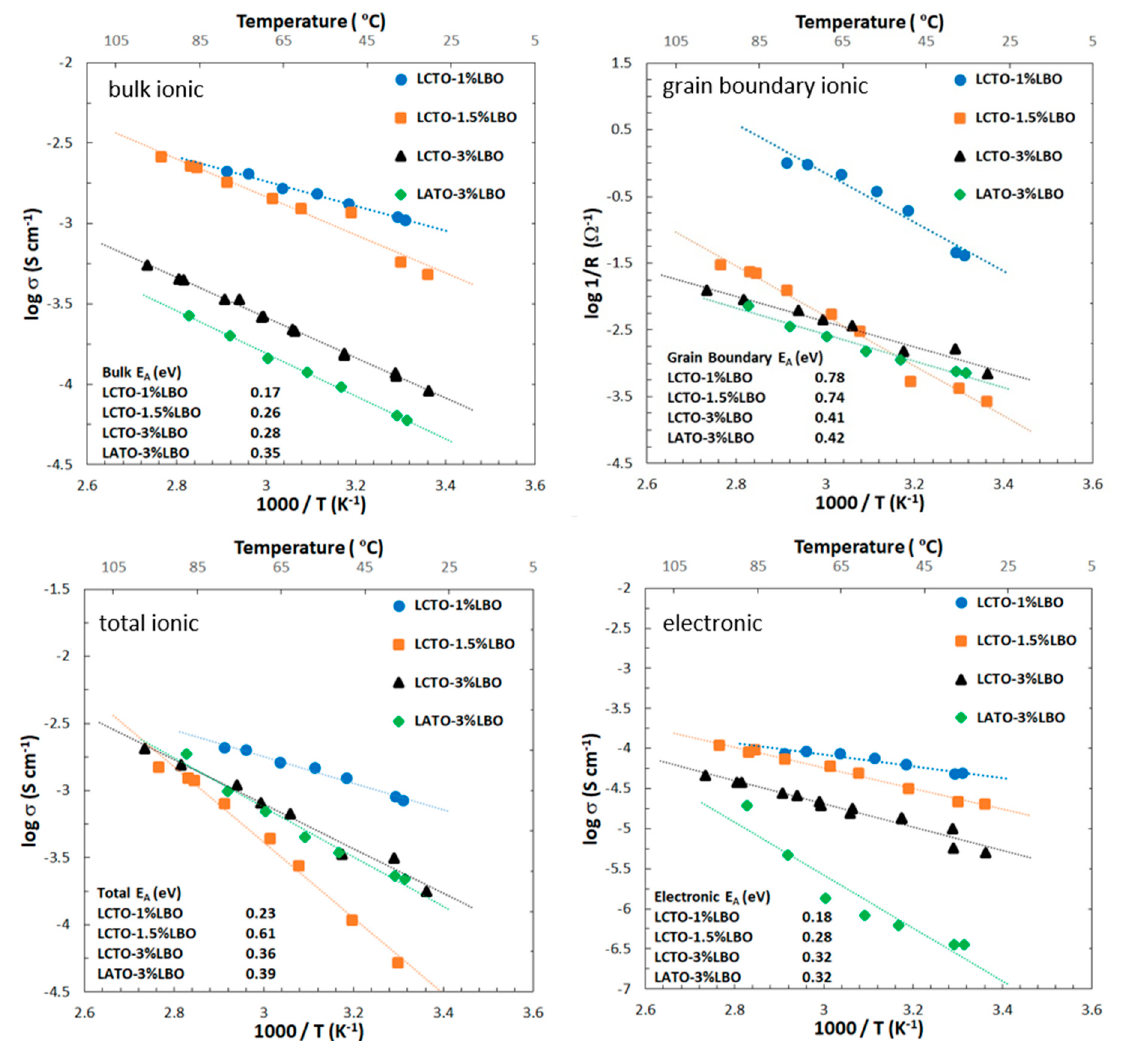
Figure 6. Bulk ionic, total ionic and electronic conductivities and (1/R gb ) grain boundary resistance plots of Li 1.25 CrTi 1.5 O 4 (LCTO) and Li 1.25 Al 0.25 Ti 1.5 O 4 (LATO) with varied weight percent Li 3 BO 3 (LBO) as a function of temperature. E A is the activation energy. Plotting (1/R gb ) was done since the grain boundary conductivity cannot be calculated because the grain boundary volume is unknown [35].